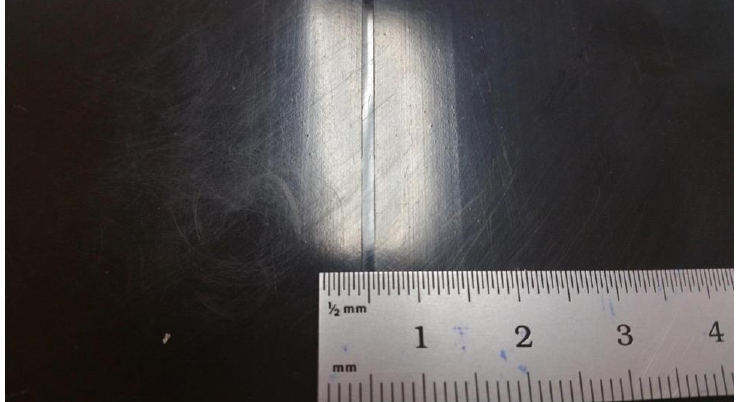
Figure 9. Representative photograph of a quality two layer LLDPE polymer laser weld. Similar surface topology, as shown, is apparent in three layer LLDPE weld systems.